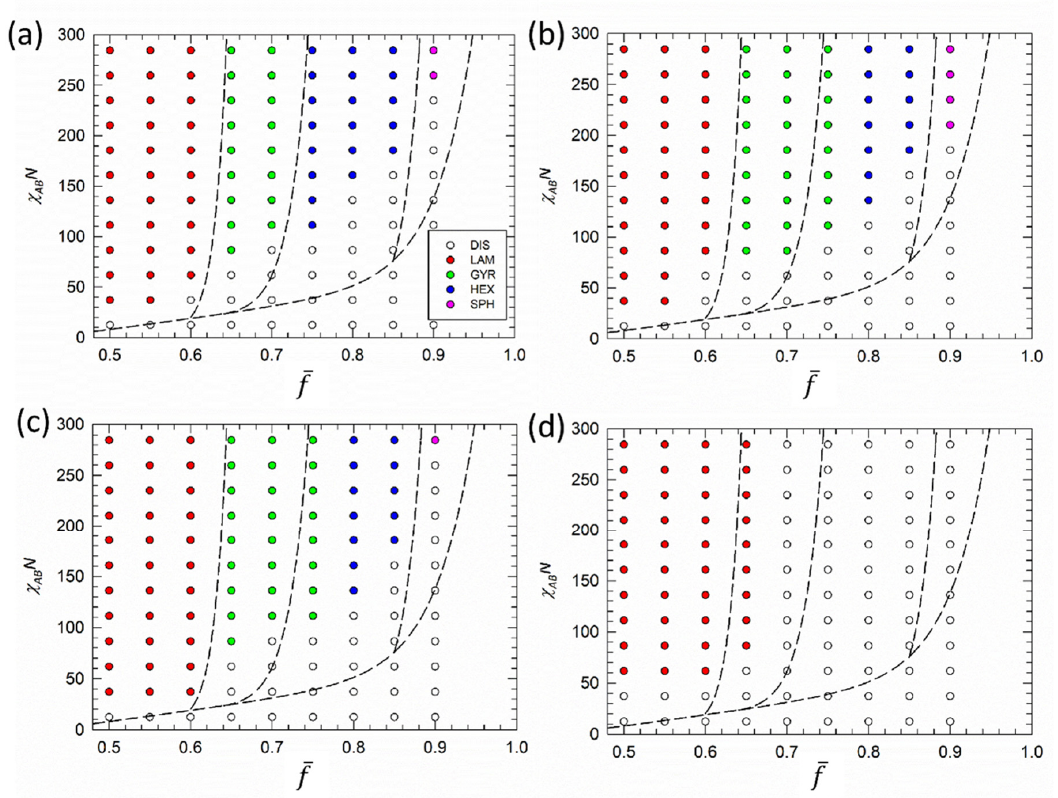
Figure 2. Gradient copolymer phase diagrams. Melts with C = {( a ) 5, ( b ) 3, ( c ) 2, ( d ) 1)} are shown in the χ AB N − f plane, where χ AB is the Flory-Huggins interaction parameter between unlike beads and f is the fraction of A segments in the copolymer chain. Symbols represent simulation points, where red circle stands for lamellae, green circle for gyroid, blue circles for hexagonally packed cylinders, and pink circles for spherical nanostructures, respectively. Open circles represent the disordered phase. Black dashed lines denote approximate phase boundaries of corresponding diblock copolymers.